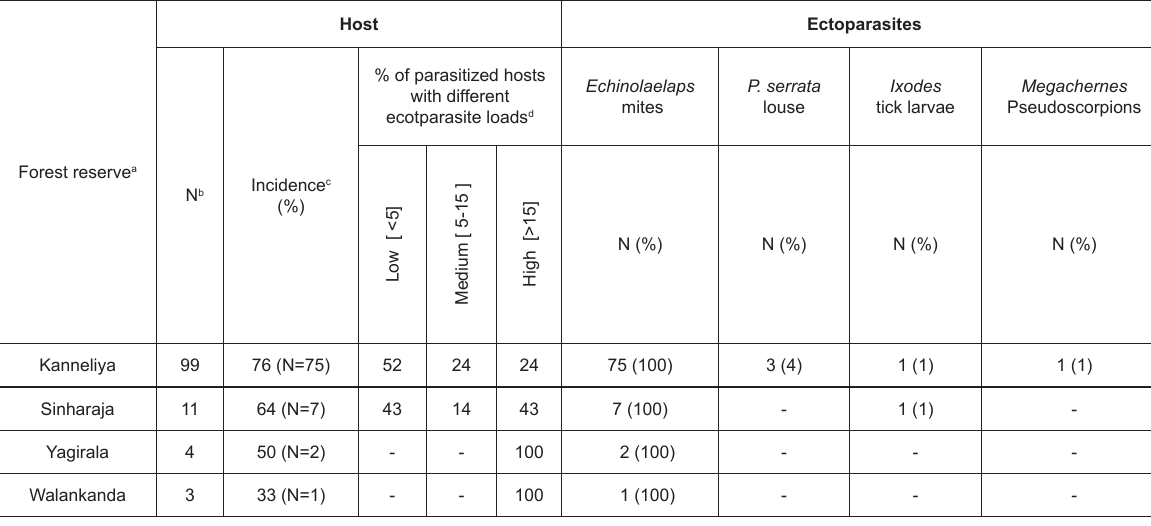
a - Kanneliya and Sinharaja - Man and Biosphere Reserves; Yagirala and Walankanda - forest patches; b - Number of hosts observed; c - % of infested individuals; d - % of parasitized hosts with different ectoparasite loads per individual Table 2. Mean body length and weight of the ectoparasite-infested and non-infested individuals of M. m. pococki captured from the four forest reserves